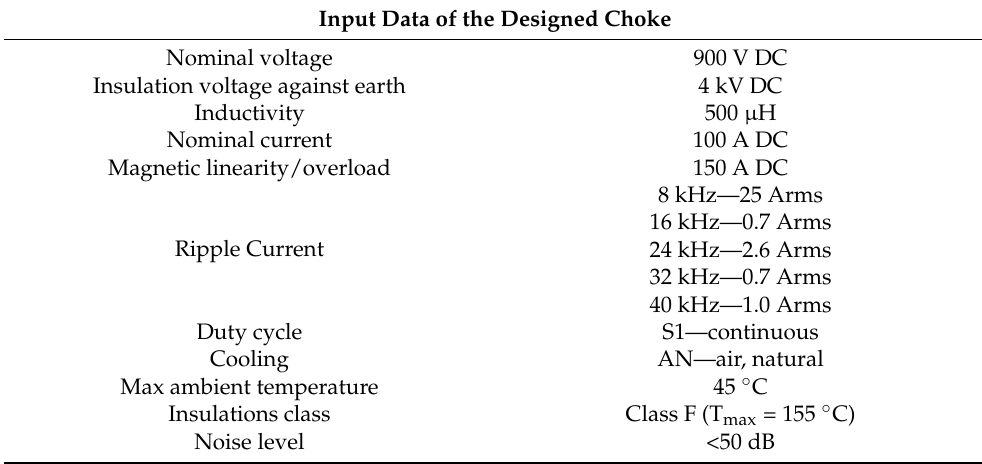
Figure 7. Electrical diagram of a DC/DC converter in the interleaved topology. Explanation for variables: CU3DC—DC circuit capacity, CoU3—output filter capacity, LoU3—phase inductances of filter chokes, iau3, ibu3, icu3—choke phase currents, S11–S13 and S21–S23—transistor switches. Table 2. Technical specification of parameters and operating conditions of chokes.